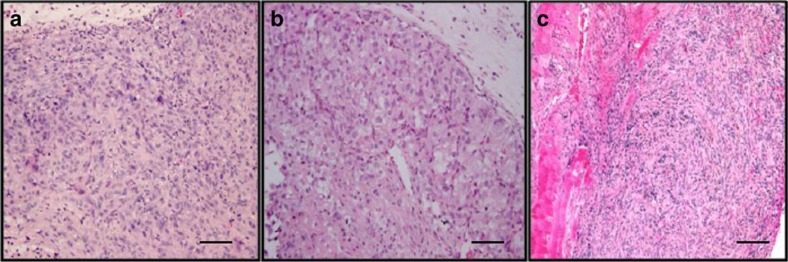
Cell Line Xenografts.Haematoxylin and eosin stain of tumour xenografts from the three most highly cited RCC cell lines (scale bar, 100 μm). (a) ACHN—xenografts show a poorly differentiated carcinoma with predominantly sarcomatoid differentiation. (b) A-498 xenografts consist of compact nests of tumour cells with clear cytoplasm, resembling the classical appearance of ccRCC. (c) 786-0 xenografts show predominantly sarcomatoid differentiation.